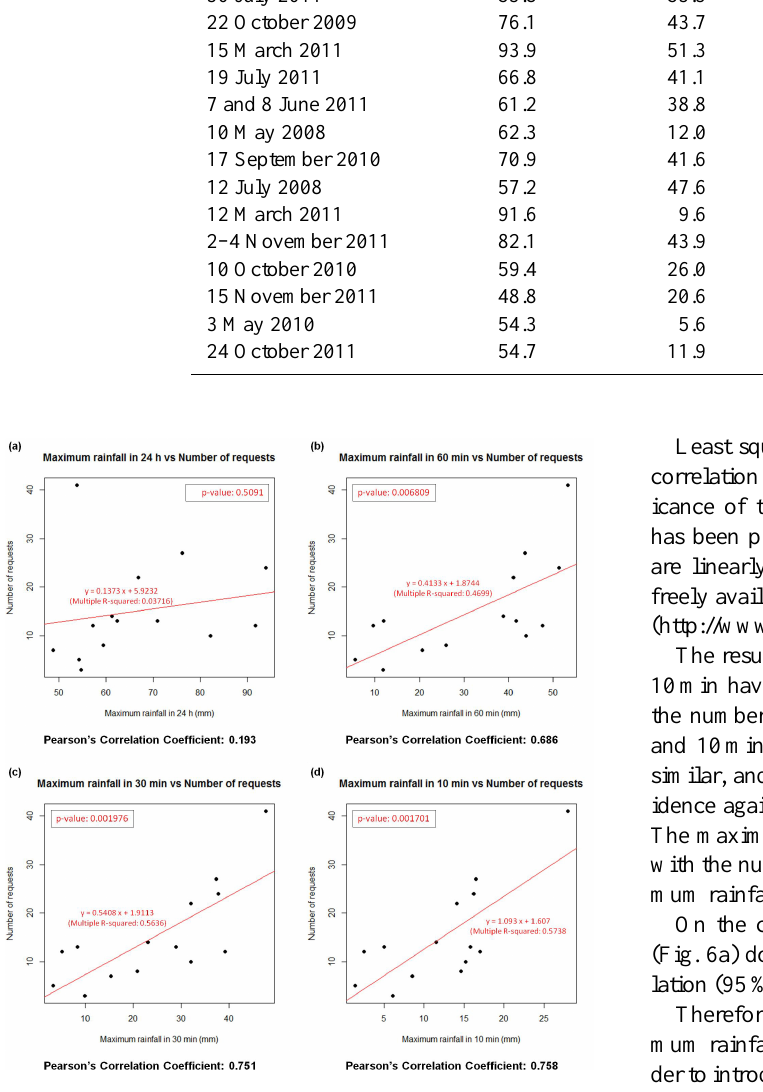
Figure 6. Correlations between number of requests and maximum rainfall in: (a) 24h, (b) 60min, (c) 30min and (d) 10min. Least squares regression has been applied. The 30 and the 10min peri- ods show the best correlation with the number of requests, and the p values near zero indicate very strong evidence against the null hypothesis of no linear